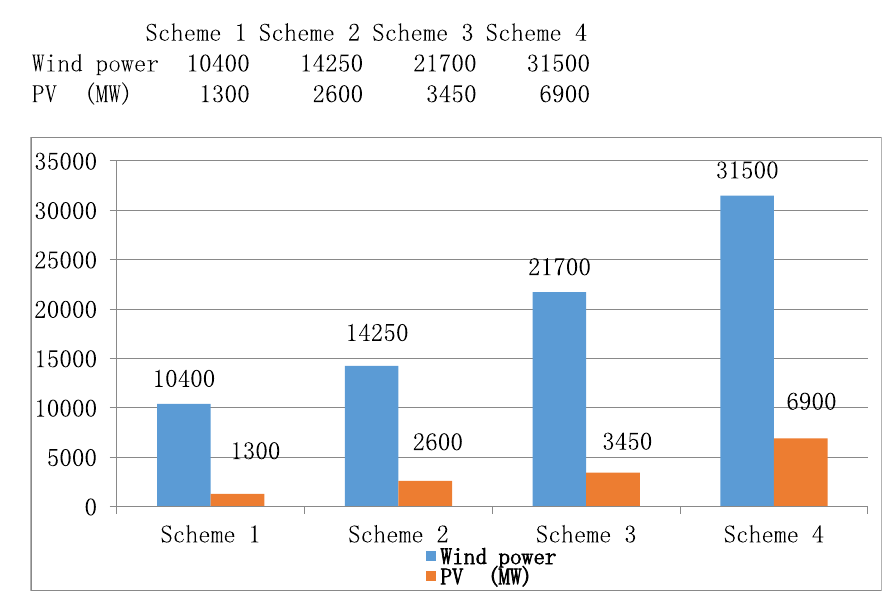
Fig. 7 Wind power and PV power accommodation capacity of Northeast region